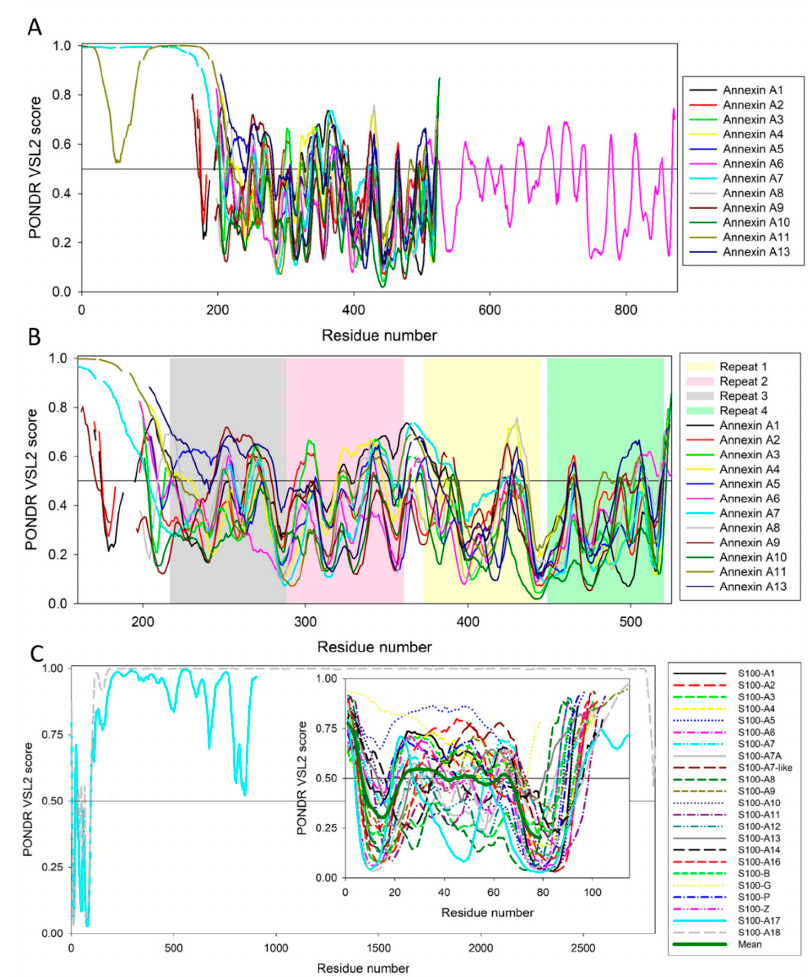
Figure 7. Evaluation of the per-residue intrinsic disorder predispositions of human annexins ( A , B ) and S100 proteins ( C ). This analysis was conducted using PONDR ® VSL2-based. Plot A contains PONDR ® VSL2-generated profiles of the aligned annexins. Plot B represents disorder profiles of aligned core domains of human annexins. Plot C shows disorder profiles of 904-residue long basalin (S100-A17) and 2850-residue-long hornerin (S100-A18). N-terminal regions of both proteins contain short (~100 residues) partially ordered domains, with the remaining 800 and 2750 residues of S100-A17 and S100-A18 being highly disordered. Inset to this plot represents PONDR ® VSL2 profiles of the N-terminal sections of these two proteins and all other human S100 proteins.